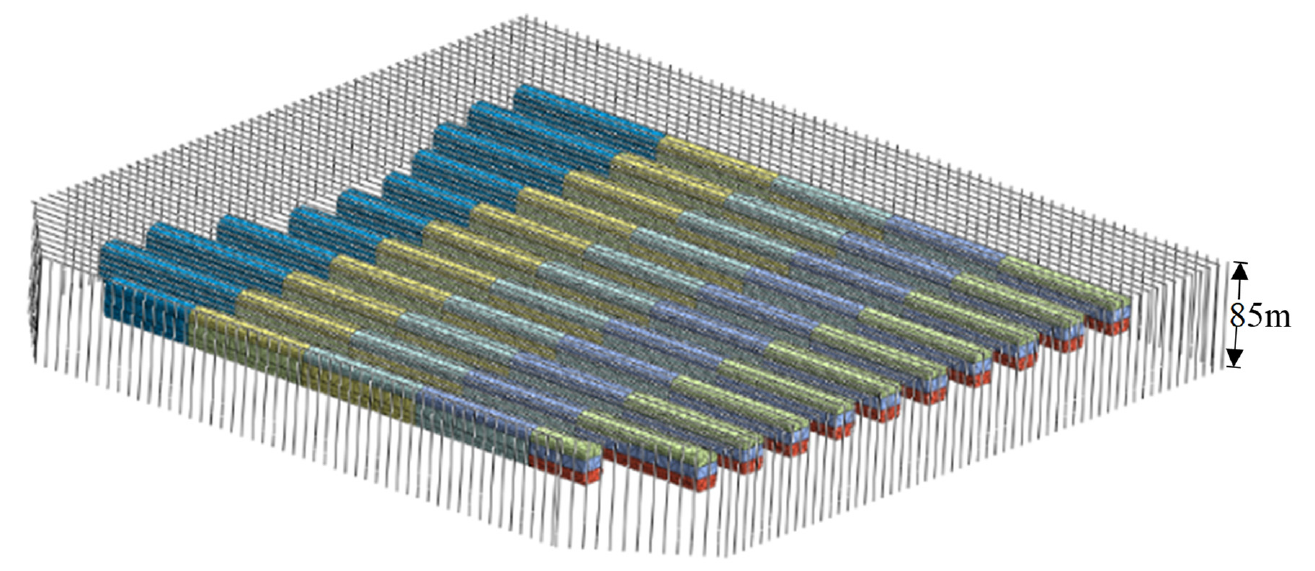
Figure 4. Schematic diagram of water curtain system around the cavern group.